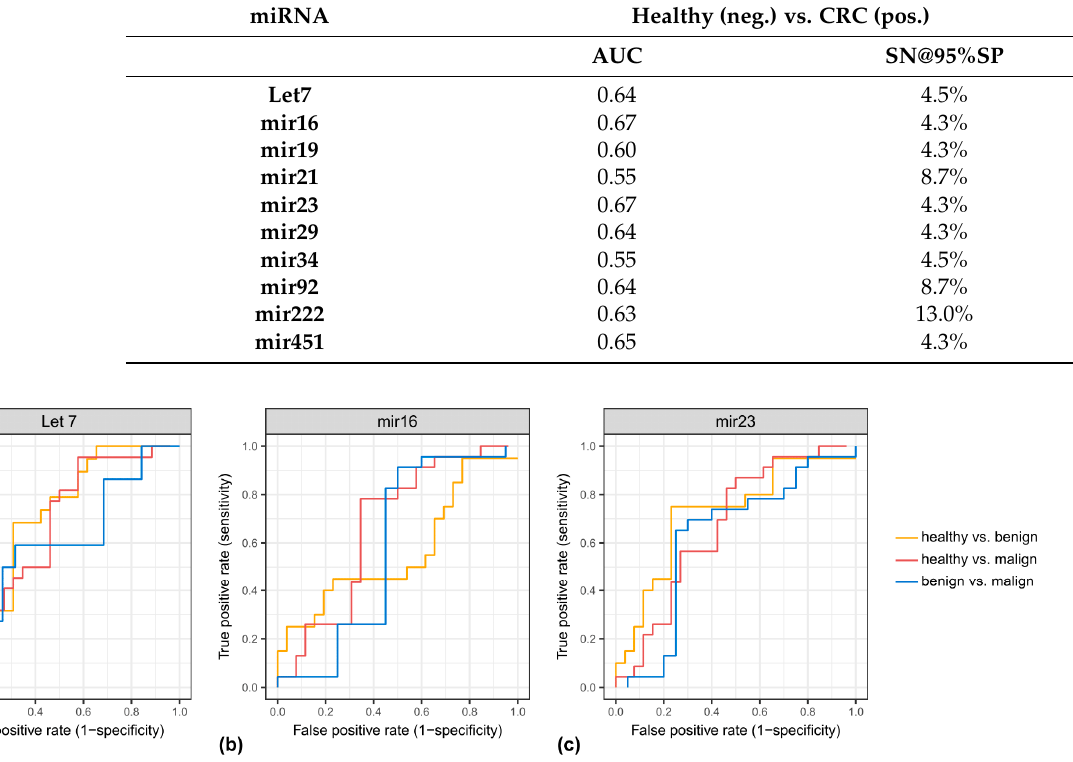
Table 4. AUCs and sensitivities at 95% specificity for different combinations of miRNA in the exosomal compartment.